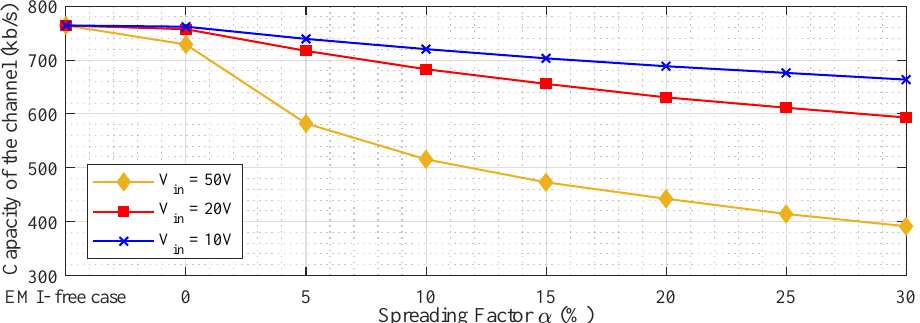
Figure 9. The PLC channel capacity in the case of several values of spreading factor with the change in input voltage amplitude of the converter.